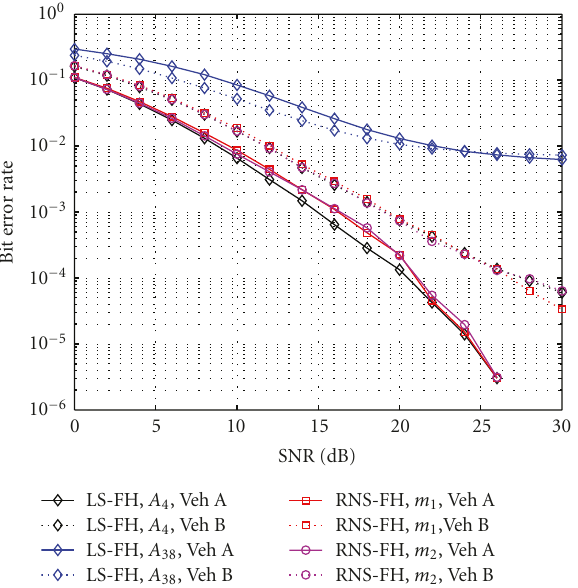
Figure 14: Performance of independent-hopped RNS-FH OFDMA versus LS-FH OFDMA, N = 110, M = M c = 10, N c = 11, LS A 4 and A 38 are used, di ff erent moduli sets m 1 = { 2,55 } and m 2 = { 2,11,5 } are applied to construct RNS-FH patterns, f